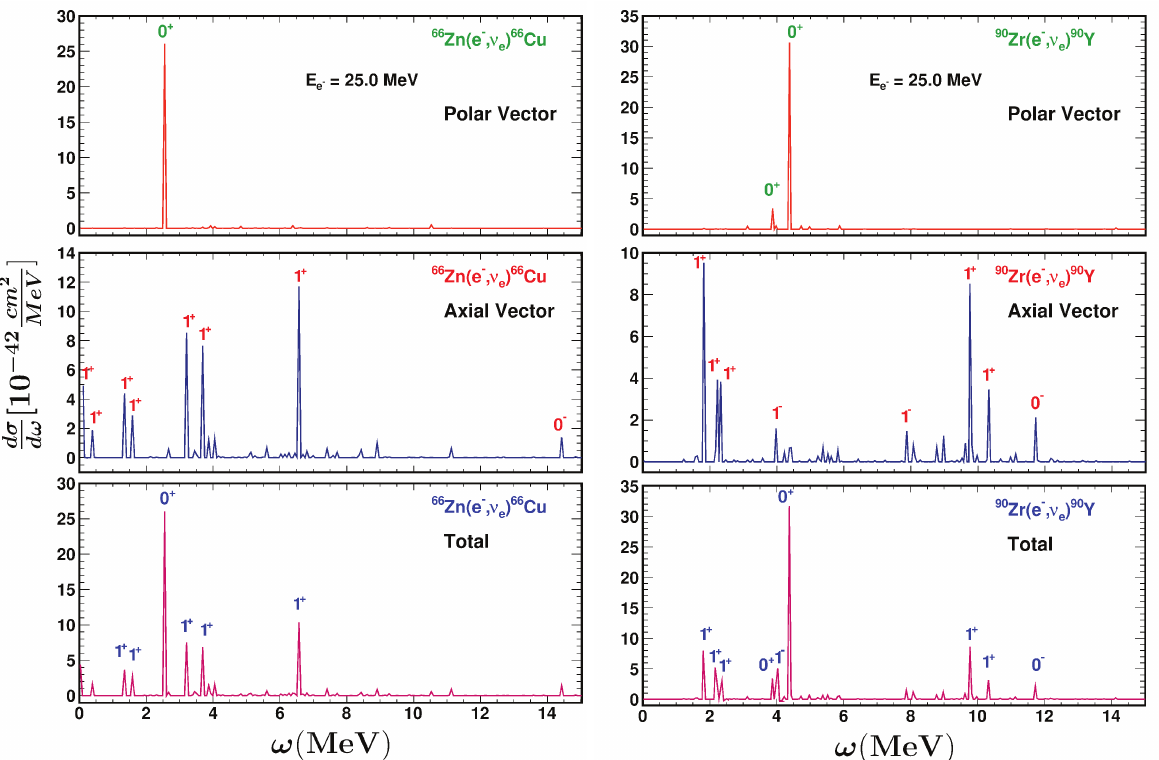
Figure 3. The same as Figure 1 but for the 48 Ti and 56 Fe